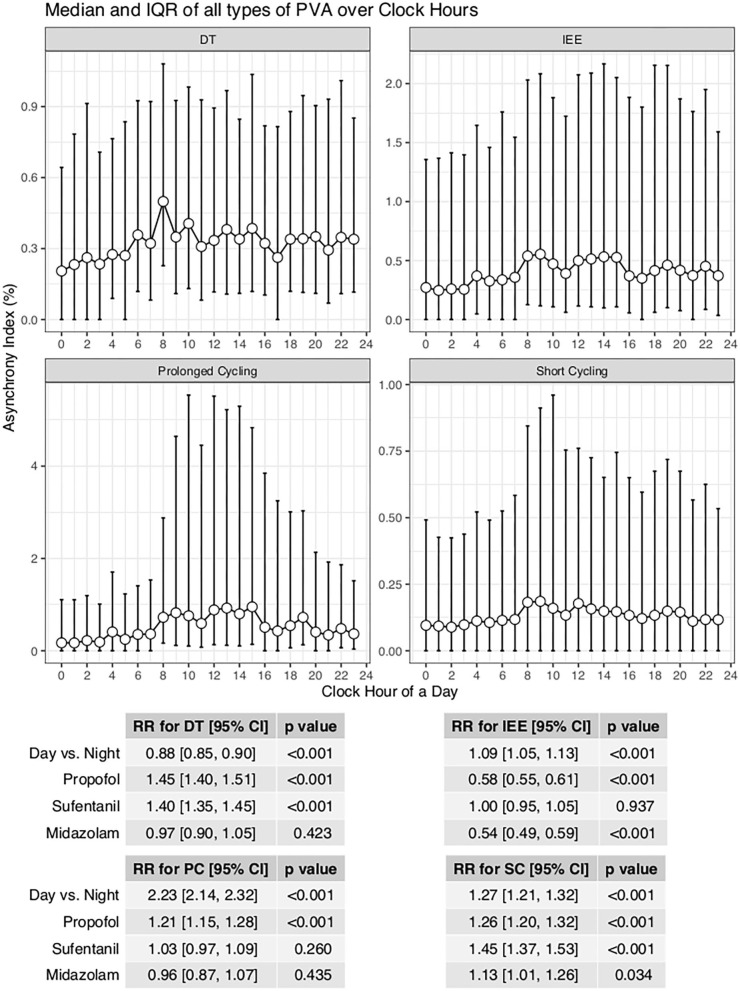
Impact of day hours on four types of asynchrony. AI was defined as the percentage of respiratory cycles with the presence of relevant types of PVA. A negative binomial regression model was built to adjust for the confounding effect of analgesics and sedatives. IEE, ineffective effort; DT, double triggering; SC, short cycling, PC, prolonged cycling.